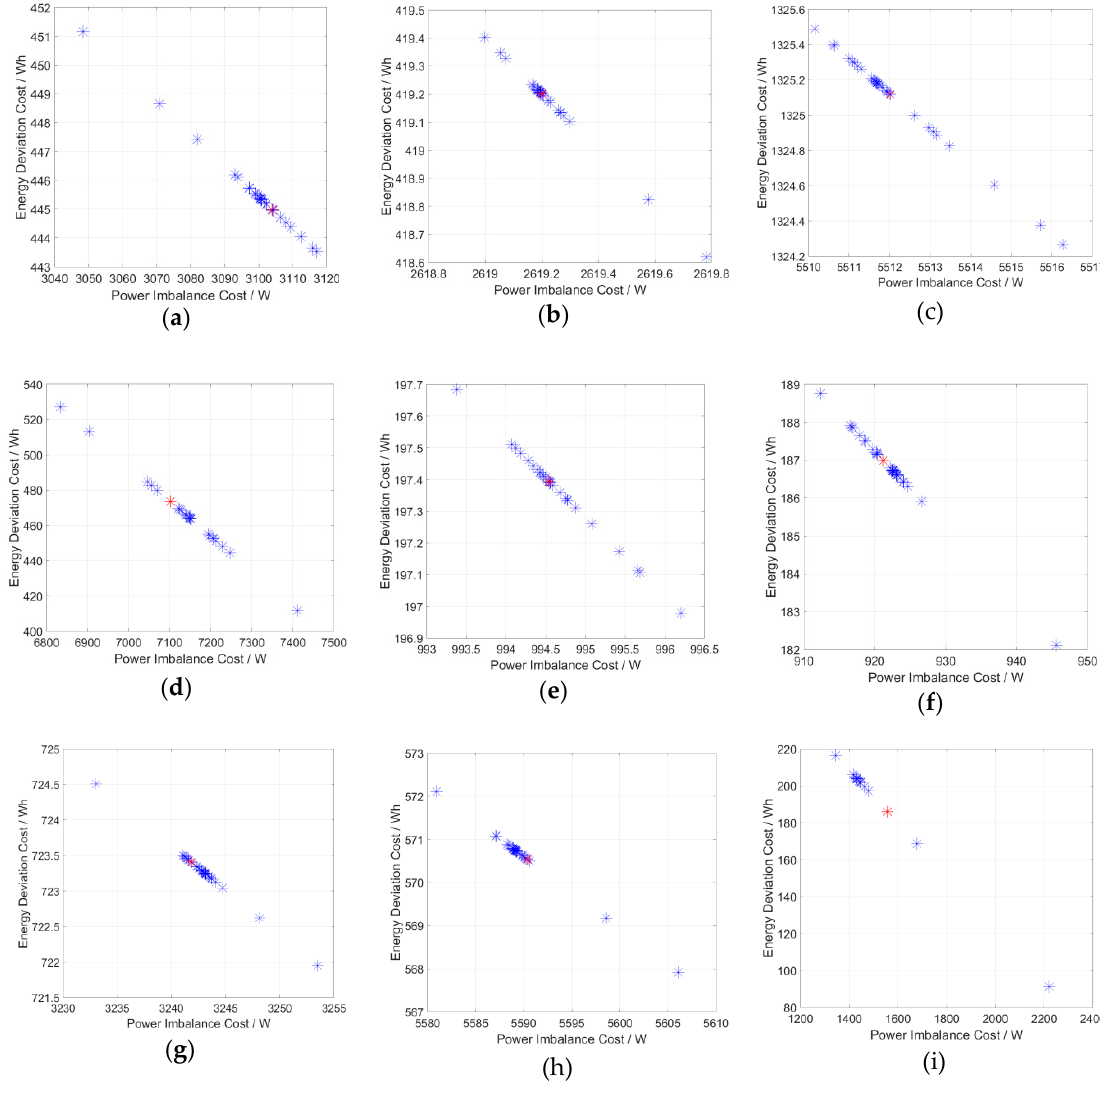
Figure 7. ParetoFrontofEVsgroupof: ( a )SoCi.class = 1,AVDTi.class = 1; ( b )SoCi.class = 1,AVDTi.class = Figure 7. Pareto Front of EVs group of: ( a ) SoCi.class = 1,AVDTi.class = 1; ( b ) SoCi.class =